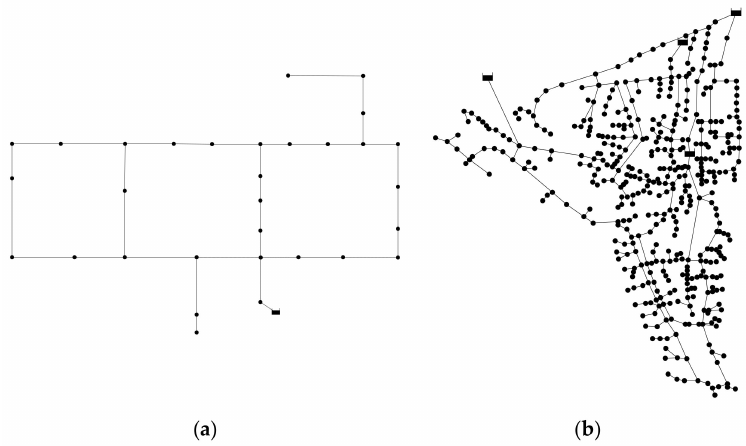
Figure 3. Layout of each benchmark network. ( a ) HAN; ( b ) BIN.